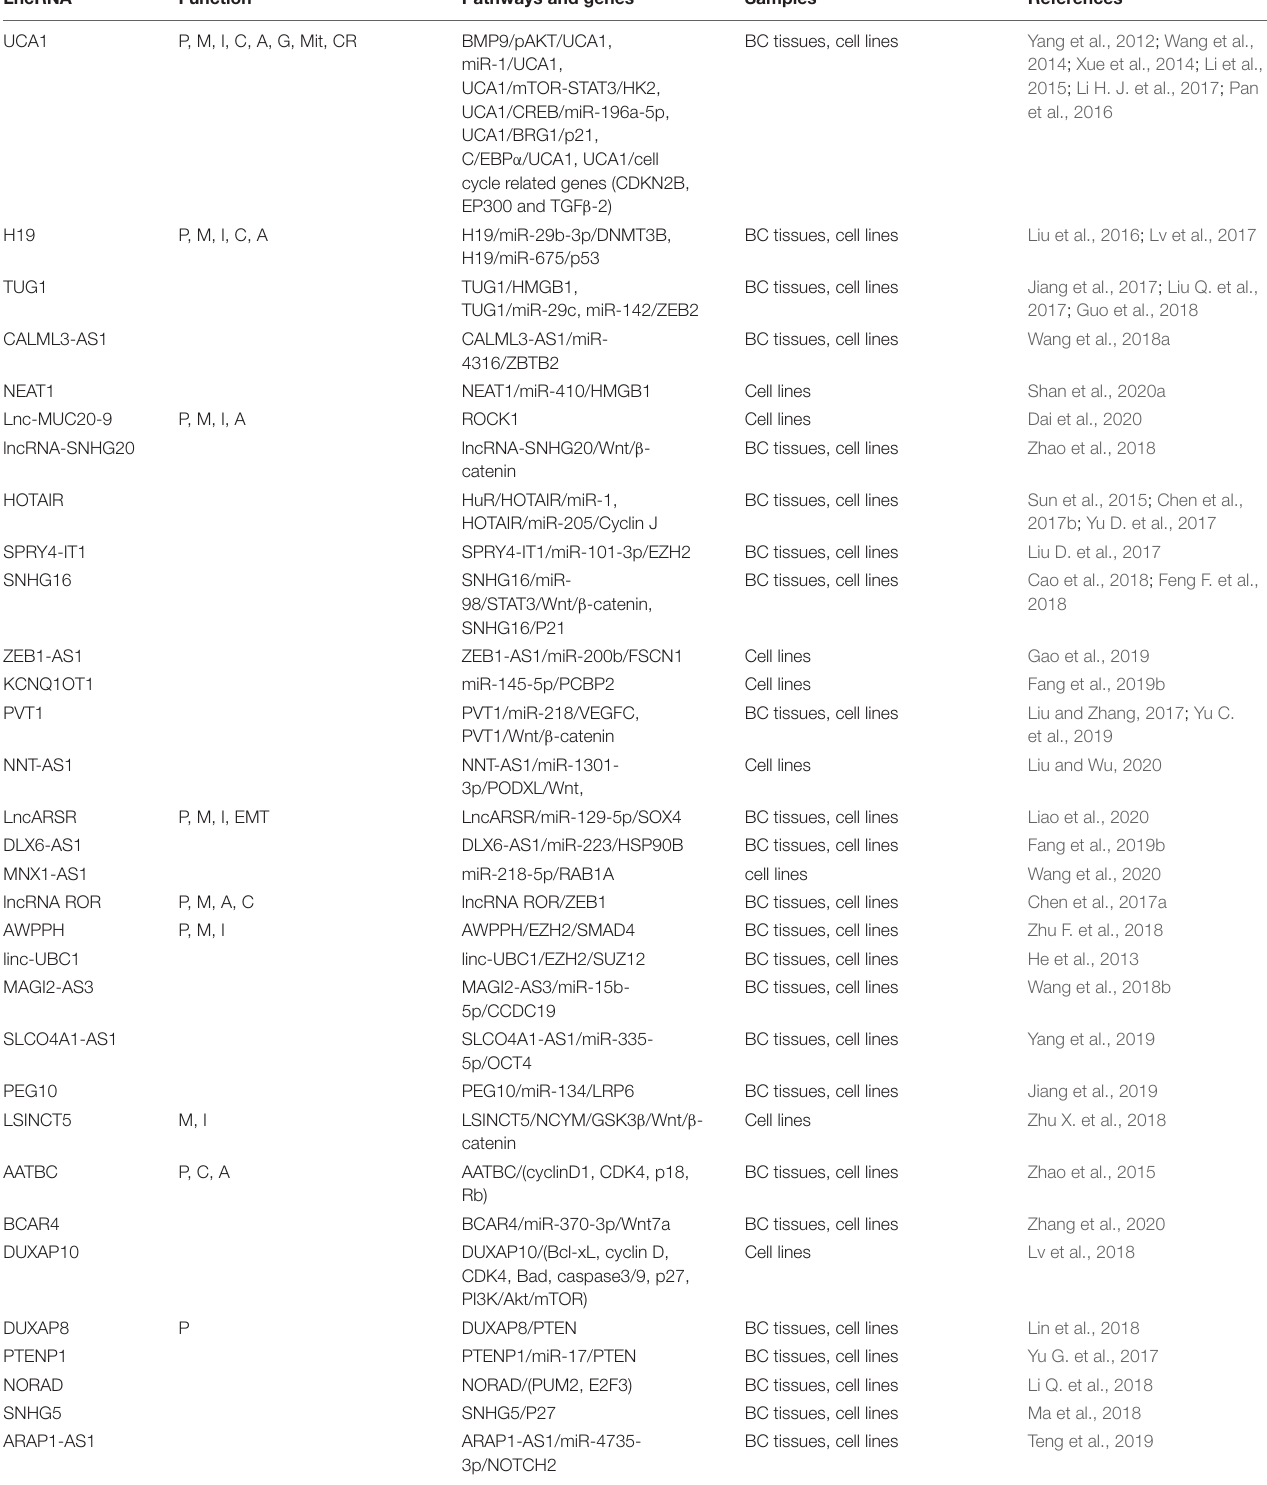
TABLE 1 | Upregulated expression, function and related gene or signaling pathway of lncRNAs in BC.